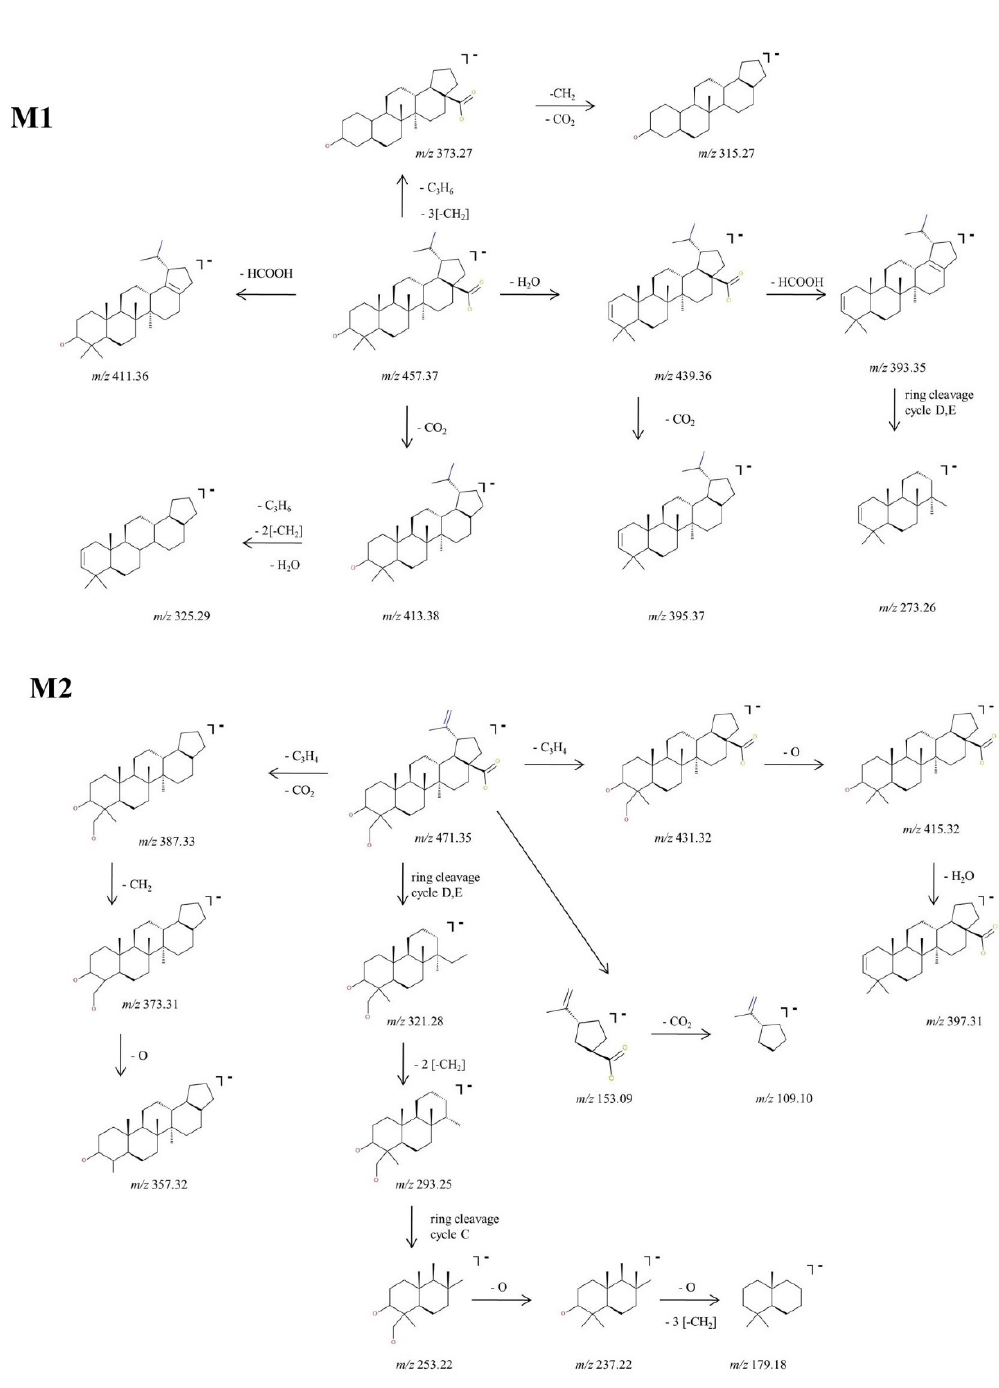
Figure 4. Proposed fragmentation pathway for phase I metabolites: M1–M2.